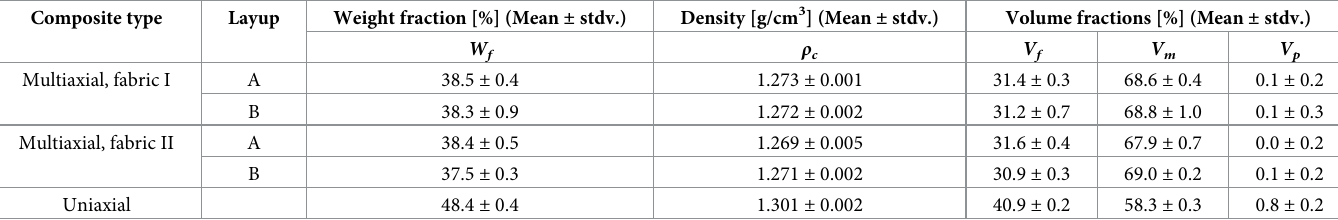
Table 2. Volumetric composition of the fabricated multiaxial and uniaxial composite laminates. Composite type Layup Weight fraction [%] (Mean ± stdv.) Density [g/cm 3 ] (Mean ± stdv.) Volume fractions [%] (Mean ± stdv.) W f ρ c Multiaxial, fabric